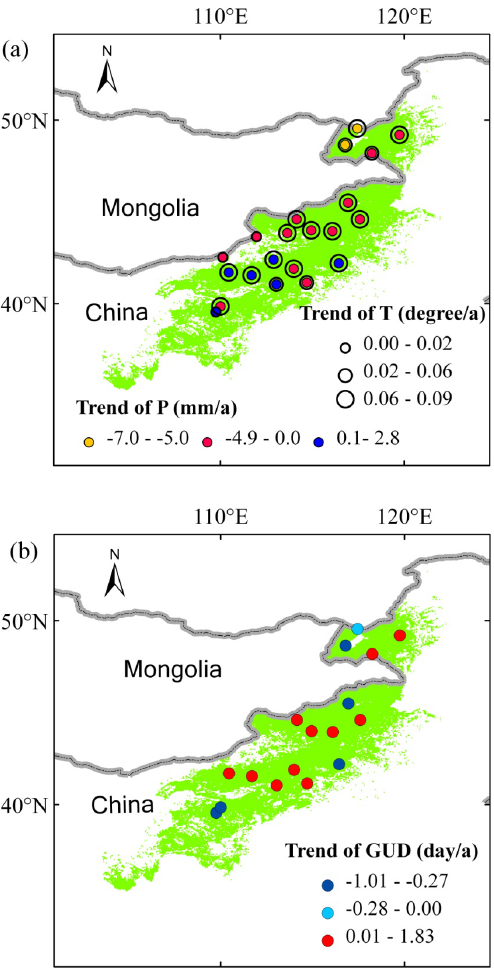
Fig. 7. (a) Trend of air temperature and precipitation in Inner Mon- Fig. 7. (a)Trend of air temperature and precipitation in Inner Mongolia from 1982 3 golia from 1982 to 2006; (b) trend of GUD in Inner Mongolia from to2006; (b) Trend of Green-up Onset Date (GUD) in Inner Mongolia from 1982 to 4 1982 to 2006. 2006. 5